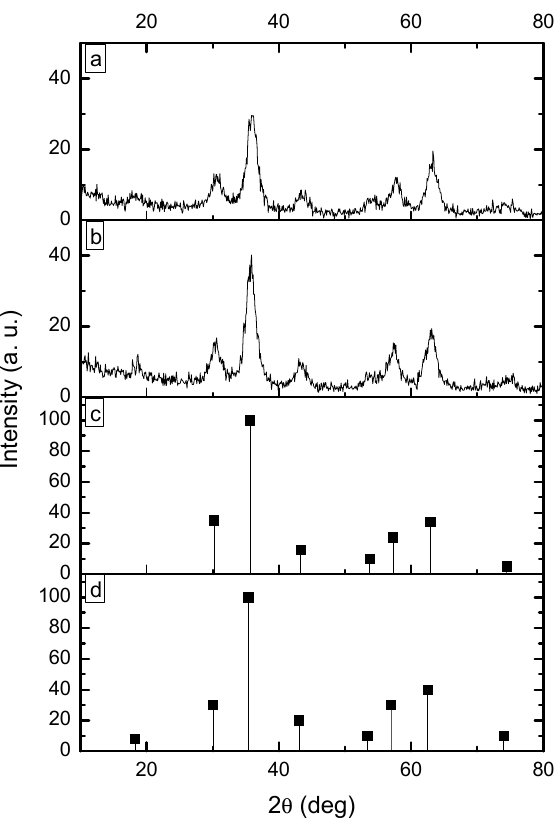
Figure 2. X-ray patterns of magnetic nanoparticles prepared by microemulsion precipitation: ( a ) without chitosan and ( b ) with chitosan. It is also included:( c ) magnetite standard pattern and ( d ) maghemite standard